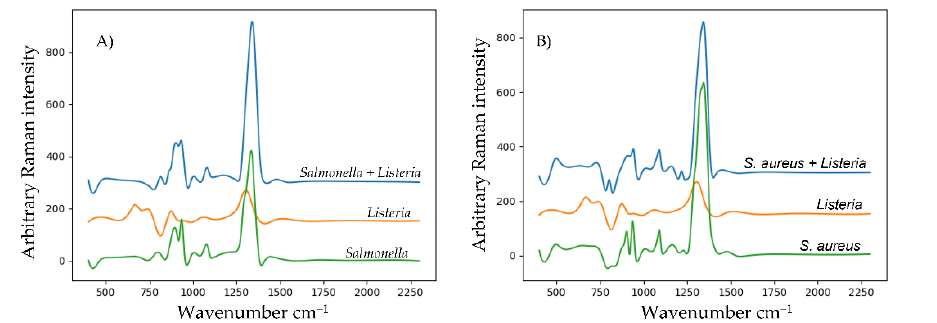
Figure 4. Comparison of control-subtracted Raman spectra (RS) of coculture mixtures and their corresponding monoculture RS components at 24 h: ( A ); L. monocytogenes and S. enterica coculture (top blue line), L. monocytogenes (orange line), and S. enterica (green line) and ( B ) L. monocytogenes + S. aureus coculture (top blue line), L. monocytogenes (orange line), and S. aureus (green line).